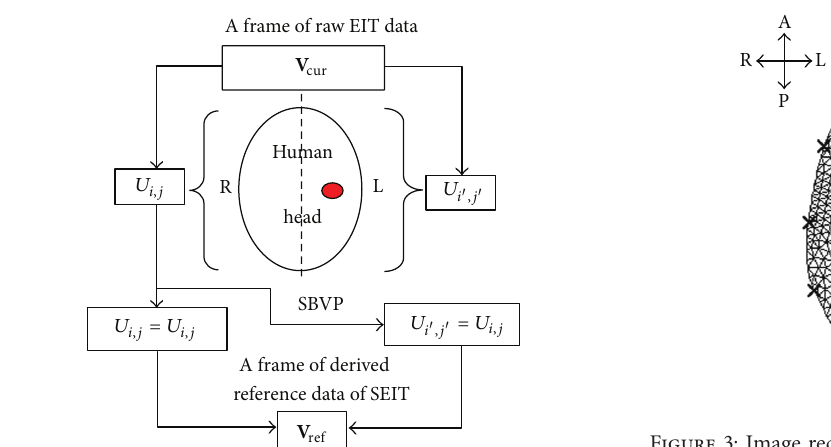
Figure 3: Image reconstruction model. The image reconstruction model consisted of 1804 triangular elements, 984 nodes, and 16 electrodes. The model was used for image reconstructions in all imaging experiments, including simulation and physical phantom experiments (A: anterior; P: posterior; L: left; and R: right).